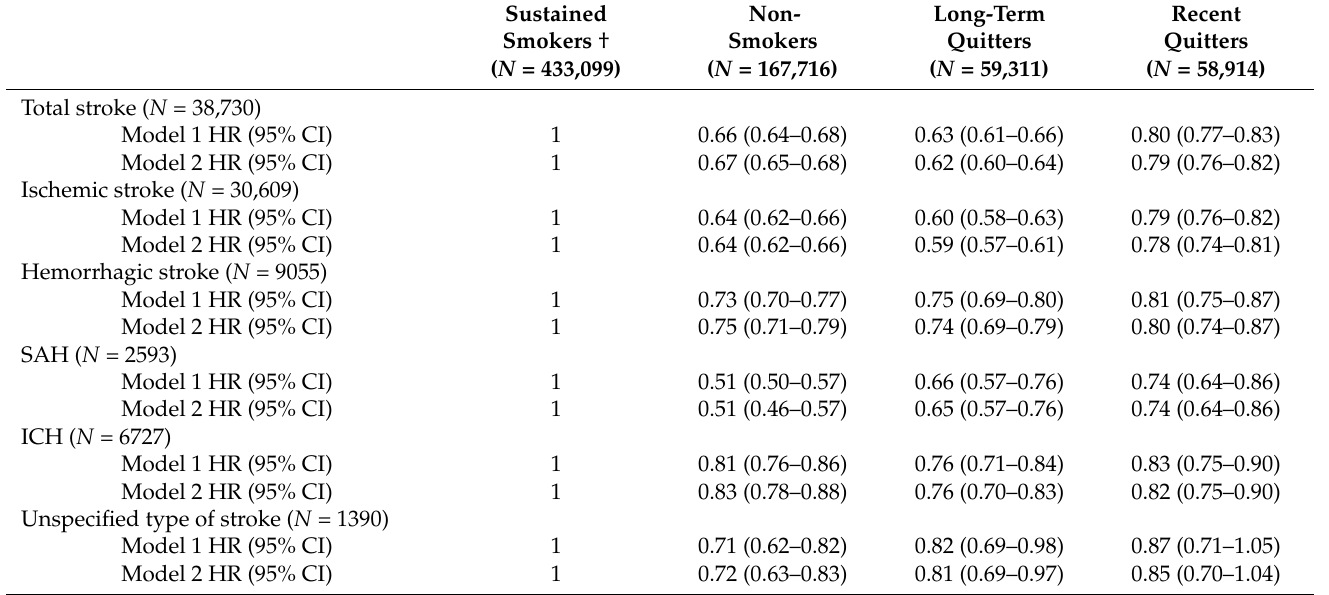
Table 3. HR and 95% CI for stroke and its subtypes, according to smoking cessation in Korean males. Long-Term Non- Sustained Smokers Smokers † ( N = 167,716) ( N = 433,099)